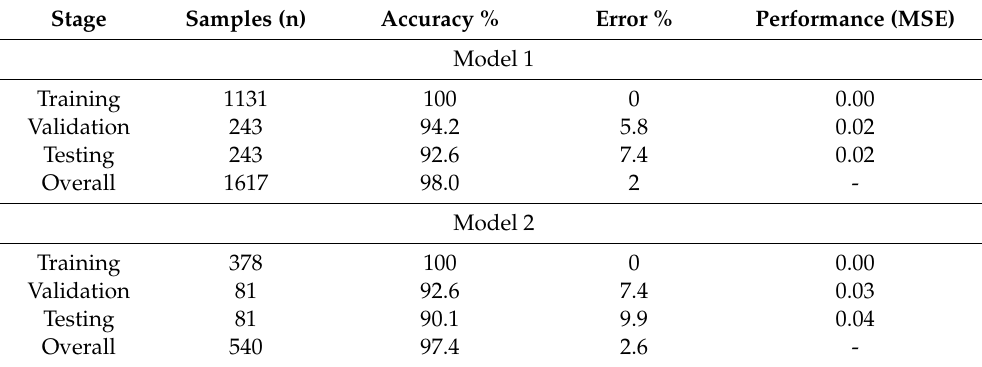
Table 4. Statistical results for the artificial neural networks pattern recognition models. Model 1: microPHAZIRTM for leaves, and Model 2: microPHAZIRTM for berries. Performance is based on means squared error